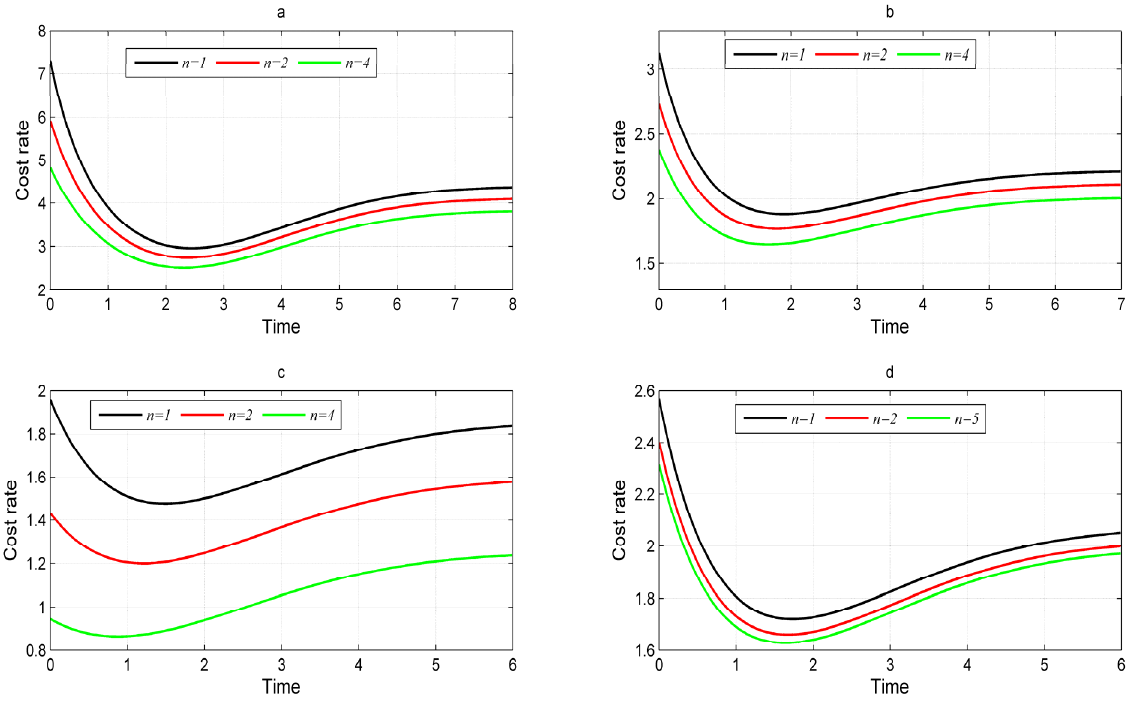
Figure 4. Cost rate under Policies 1–4. ( a ) (Policy 1), ( b ) (Policy 2), ( c ) (Policy 3), ( d ) (Policy 4).